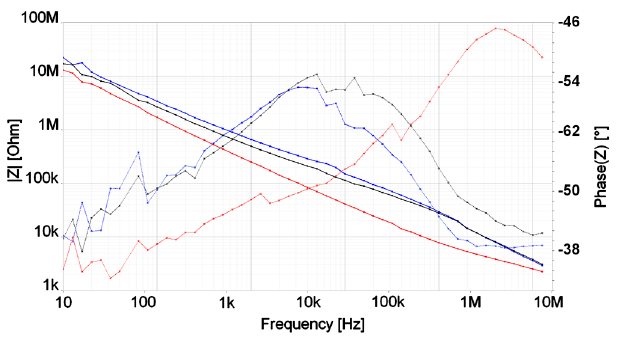
Figure 4. An impedance measurement example for electrode 33 MEA 2 at Day 1 (Black), Day 10 (Red) and without cells (Blue).Solid line = Modulus, Dotted line =